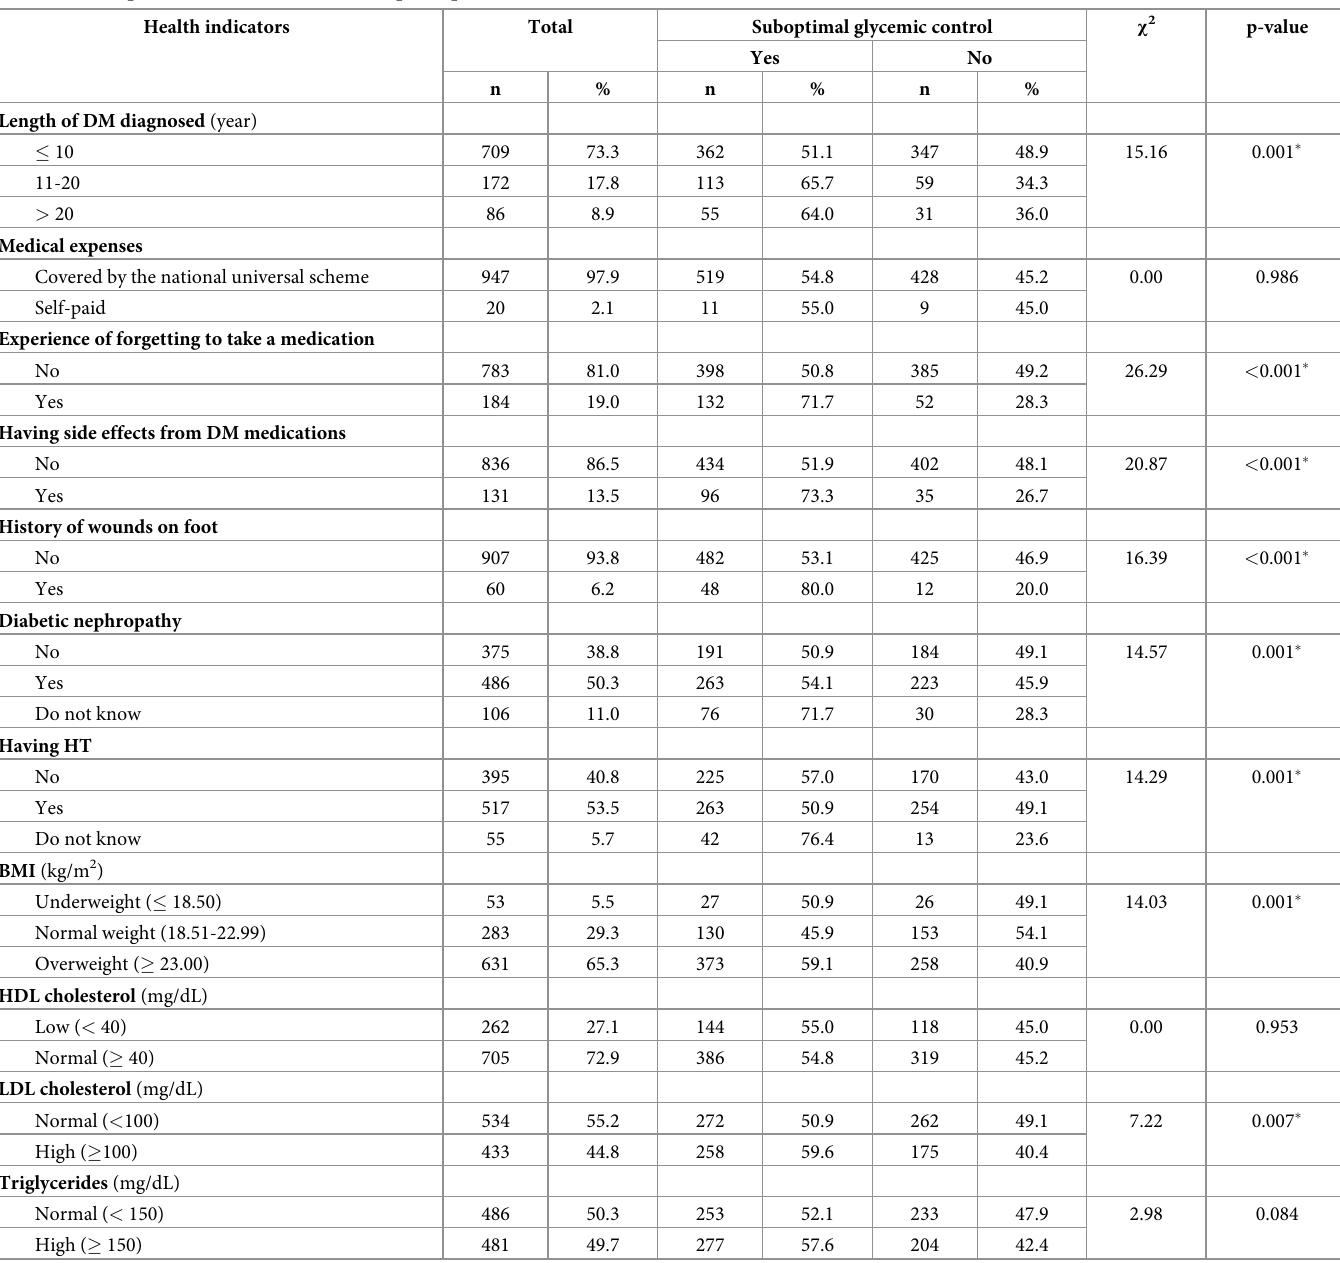
Table 3. DM experiences and biomarkers of the participants. Health